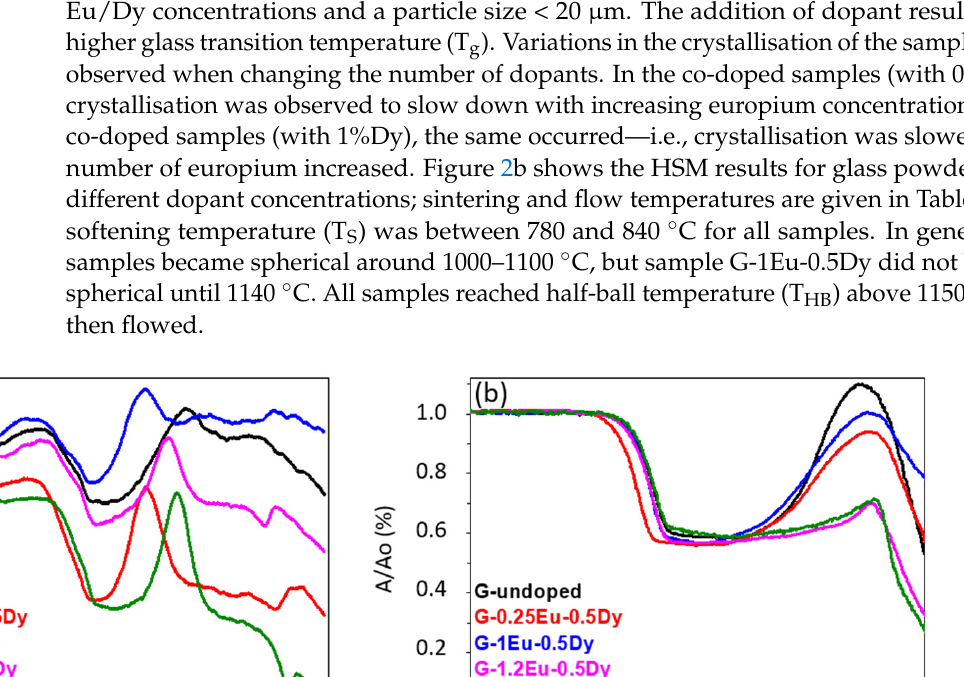
1195 The combination of DTA and HSM results indicated that heat treatment of the glass powders up to 1100 °C can provide suitable sintering, crystallisation, and flow stages, thus allowing the production of glass ‐ ceramic in bulk or enamel form as possible final prod ‐ ucts. The densities of the glass ‐ ceramics were measured by the Archimedes method, but for the density of the glass samples, we adopted the value of the melts in an electric fur ‐ nace as a reference, since, as previously mentioned for the gas furnace, the glass melted in a glass frit form. The average density of the glass melted in the electric furnace was about 3.31 g ∙ cm − 3 , and the density of glass ‐ ceramics is presented in Table 5. The theoretical den ‐ sity of the main crystalline phase, Sr 2 MgSi 2 O 7 , was 3.7 g ∙ cm − 3 , while the highest density obtained for the glass ‐ ceramics was 3.27 g ∙ cm − 3 for GC ‐ 1Eu ‐ 0.5Dy. Although it was not quantified, there was a high residual porosity in some of the samples.